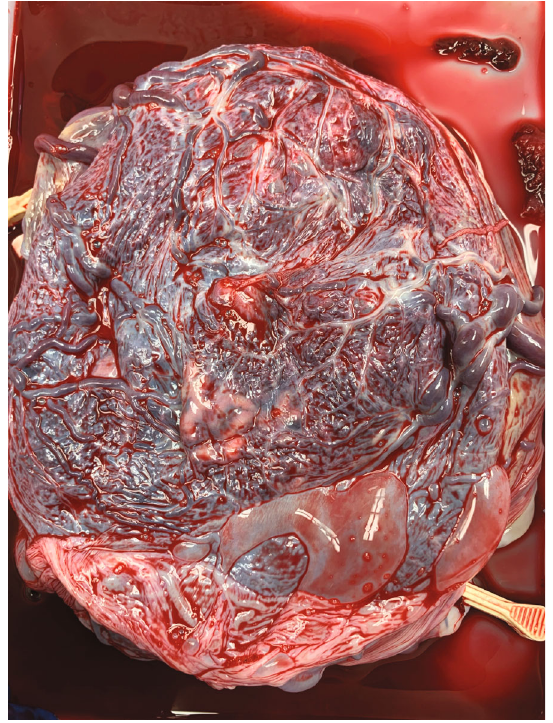
Figure 4: The placenta of the monochorionic diamniotic